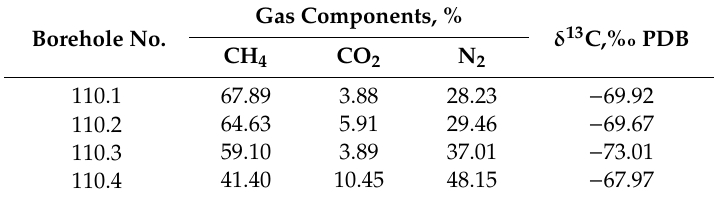
Table 2. Gas components and δ 13 C (in methane) in gryphons around boreholes, Zapolyarny field [89].